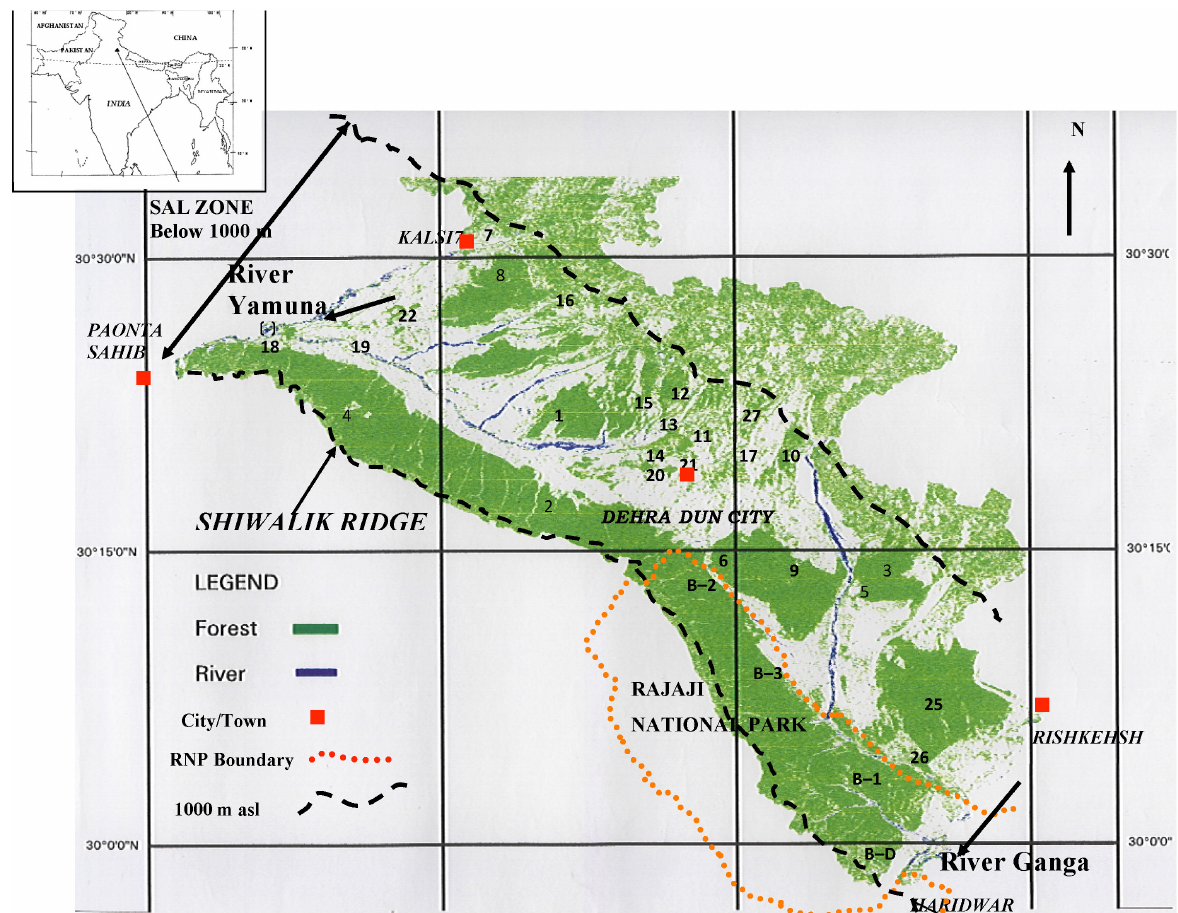
Figure 2. Map of Dehradun Valley depicting the extent of sal forest cover and butterfly sampling sites as mentioned in Table